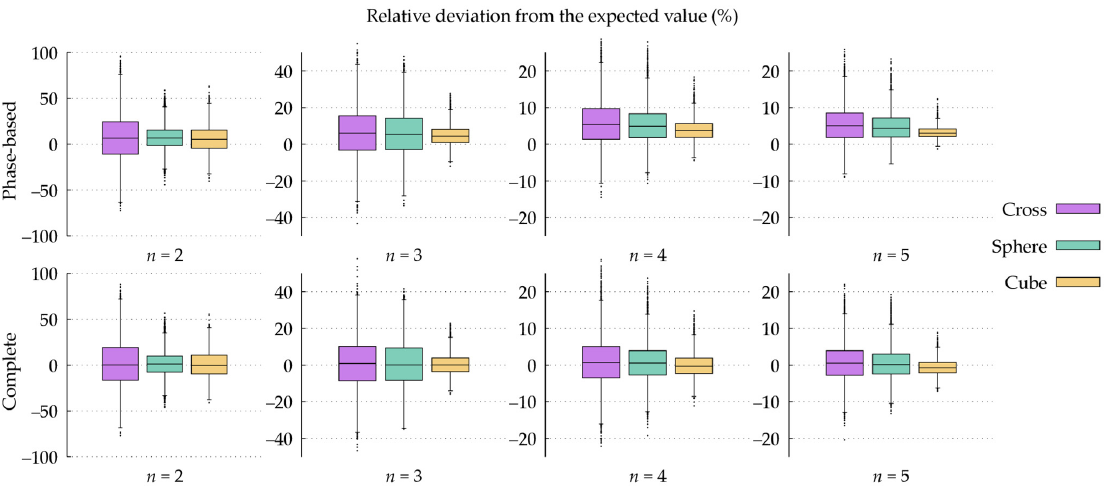
Figure 4. Boxplots of the relative deviation from the expected value ( σ exp = 560 mS m − 1 ) of the mean electric conductivity maps estimated by Helmholtz ‐ EPT under repeatability conditions when different shapes and sizes of the kernel of the Savitzky–Golay filter are used. The top row shows the results of the phase ‐ based method (3), whereas the bottom row shows those of the complete method (1).